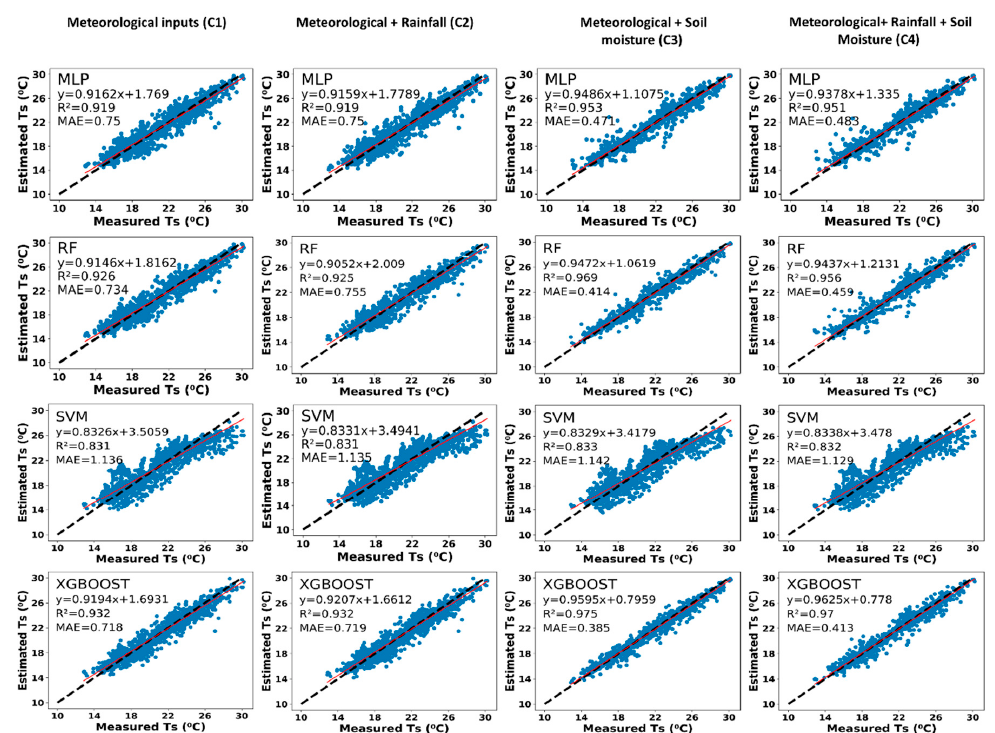
Figure 9. Scatter plots between estimated and measured hourly soil temperature (Ts) showing R 2 and MAE of 16 different model combinations for grassed hillslope (black dashed line represents 45 degree line and red solid line represents regression line).